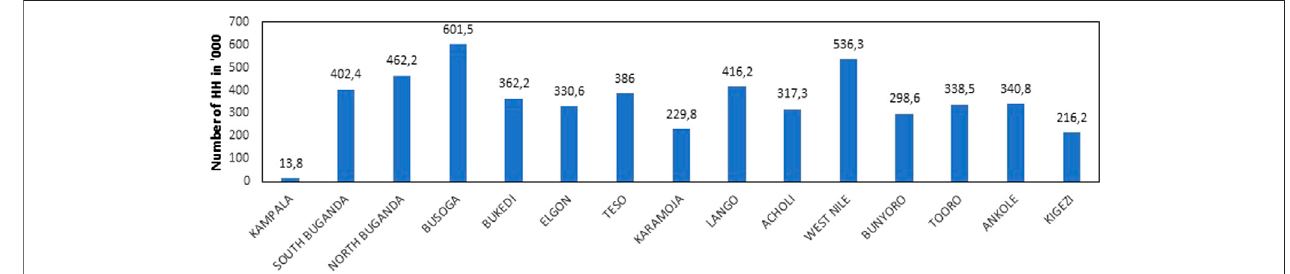
FIGURE 3 | Number of households without access by sub-region (Solar market potential).